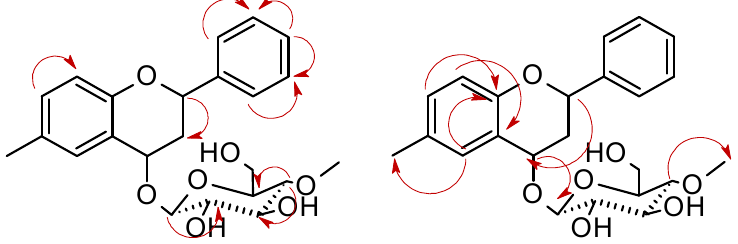
Scheme 12. Key COSY (on the left) and HMBC (on the right) correlations for the structure elucidation of product 4f .